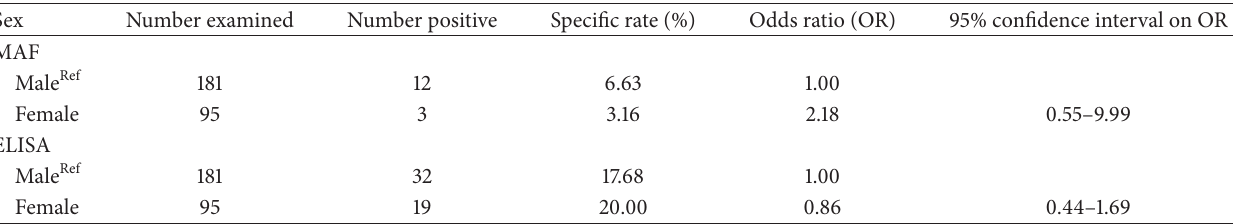
Table 4: Odds ratio and 95% confidence interval on effect of sex on the prevalence of Cryptosporidium infection in dogs using MAF and ELISA in the FCT,